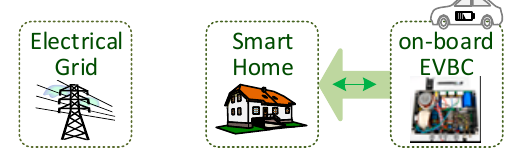
Figure 11. On-board EVBC: Vehicle-to-home (V2H) operation mode (as an off-line uninterruptible power supply).